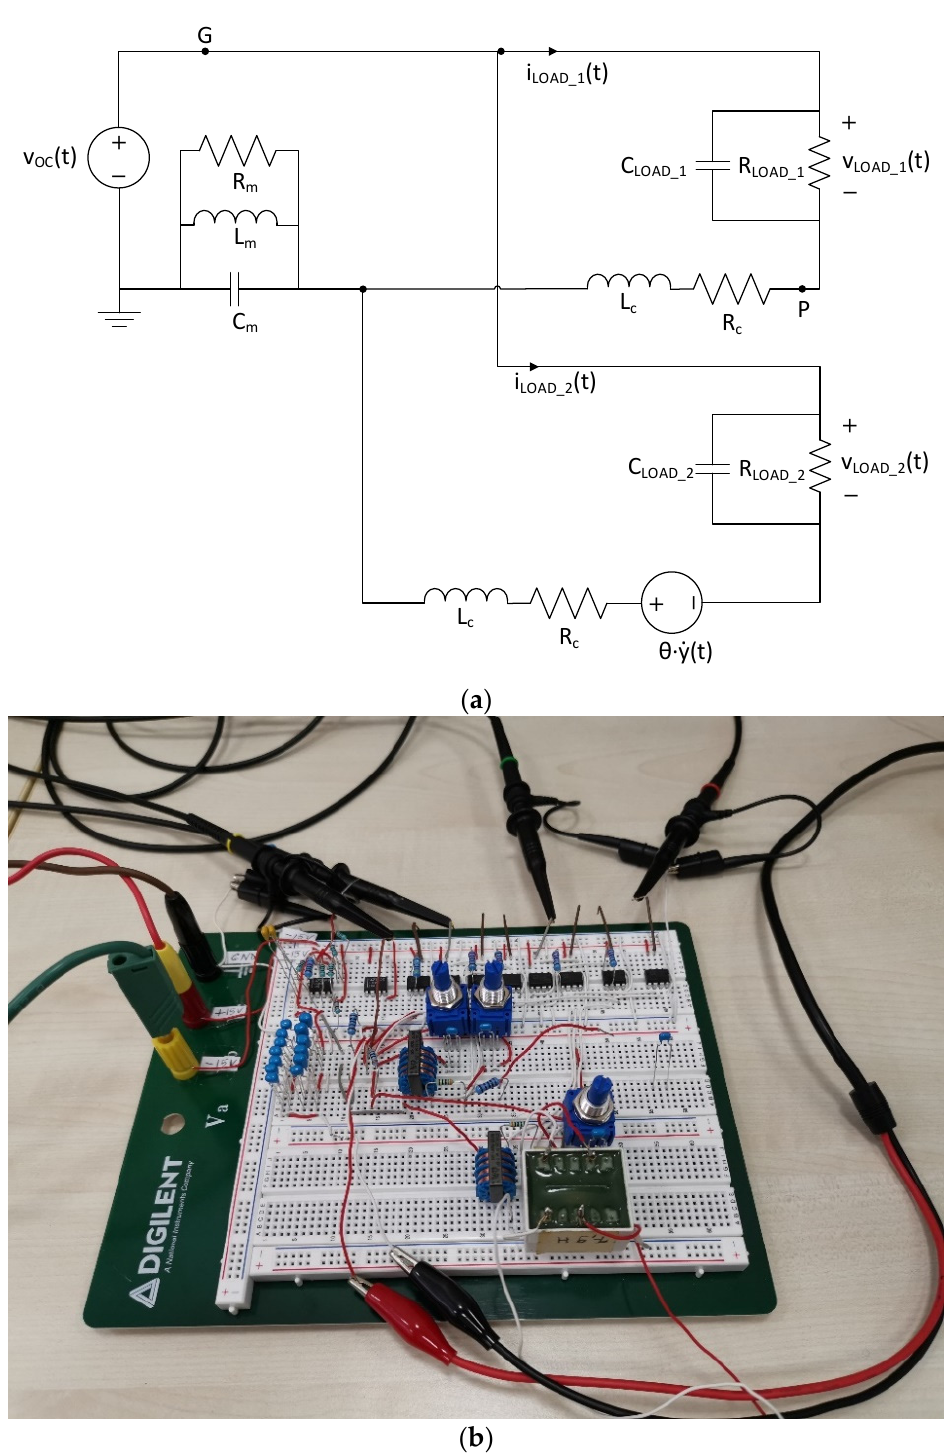
Figure 11. ( a ) Alternative form of the equivalent circuit of a double coil electromagnetic harvester. ( b ) Experimental implementation of the electromagnetic harvesters by using electronic components.